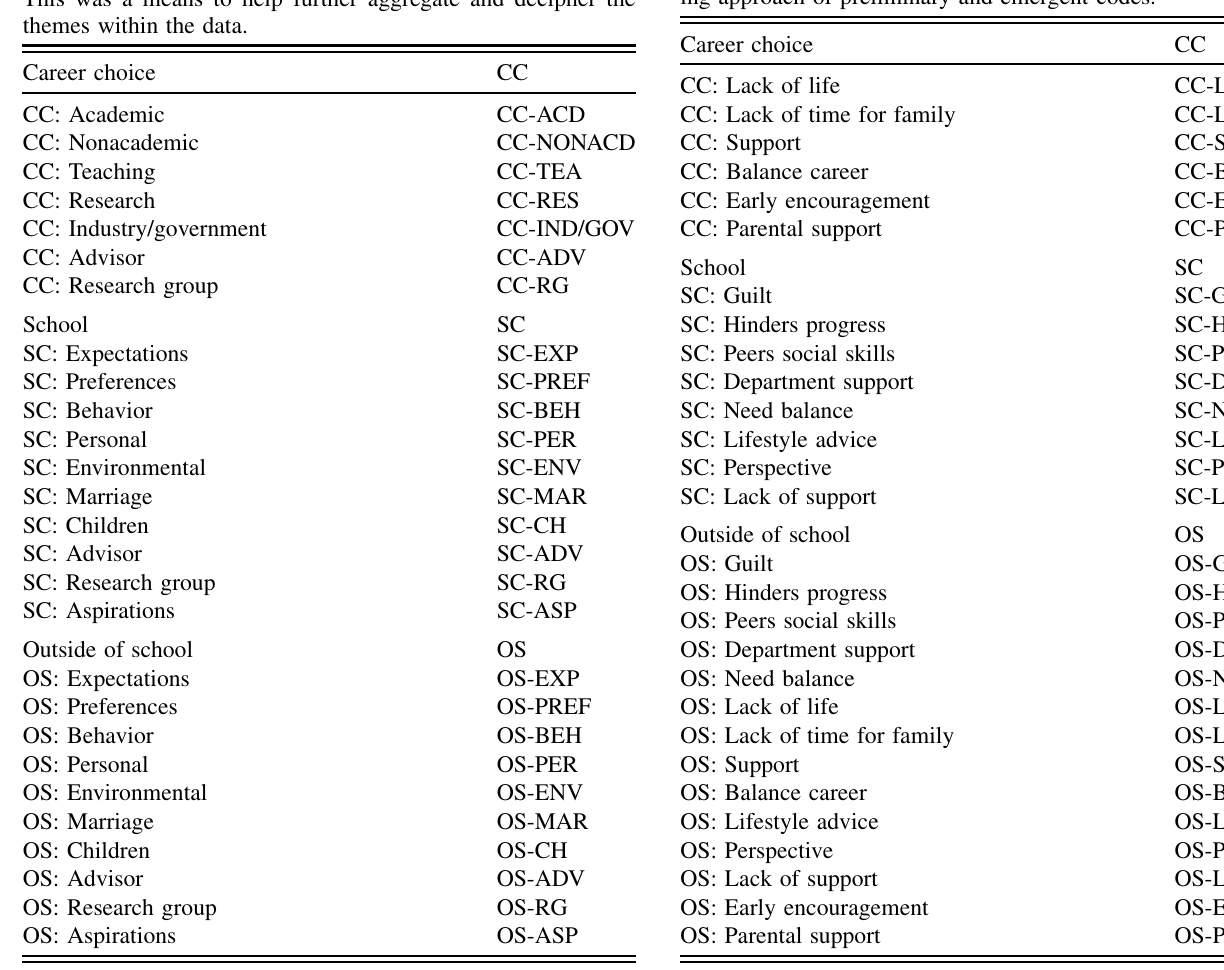
TABLE III. Final code list developed through a blended cod- ing approach of preliminary and emergent